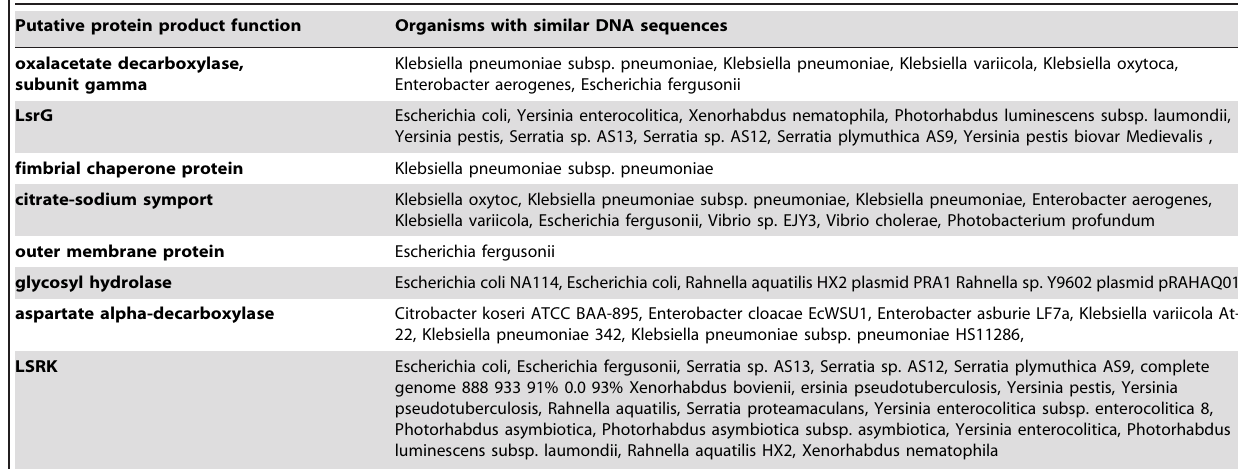
Putative protein product function Organisms with similar DNA